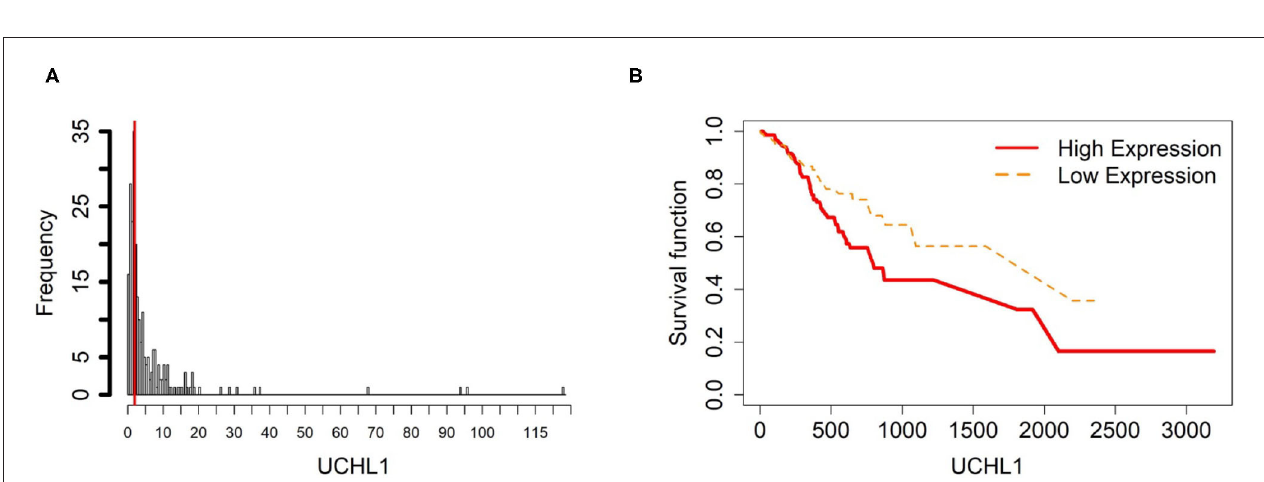
0.0325 indicates a significant survival time difference =